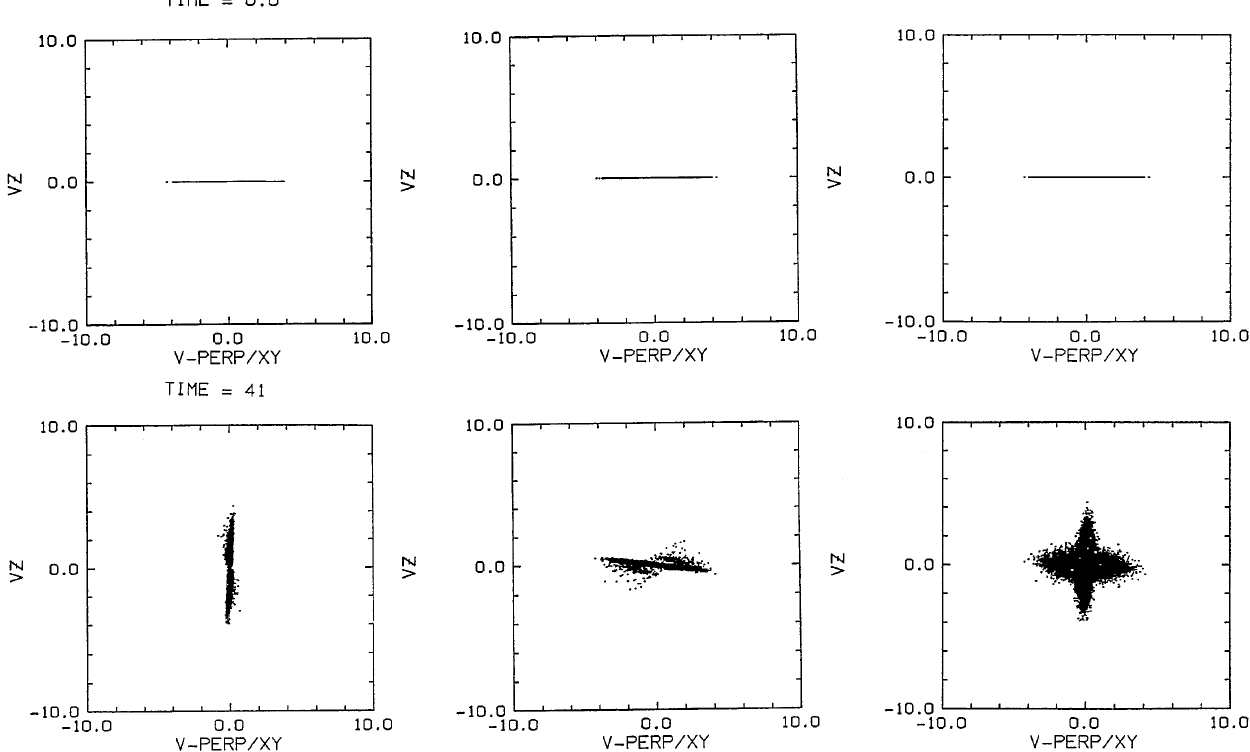
Fig. 6. Distributions of the perpendicular velocities of the nongyrotropic populations at the beginning ( t (cid:136) 0: upper panel ) and end ( t (cid:136) 41: lower panel ) of the simulations (V-PERP/XY=VX). From left to right: runs F, P, and PF. Velocity normalization defined in the